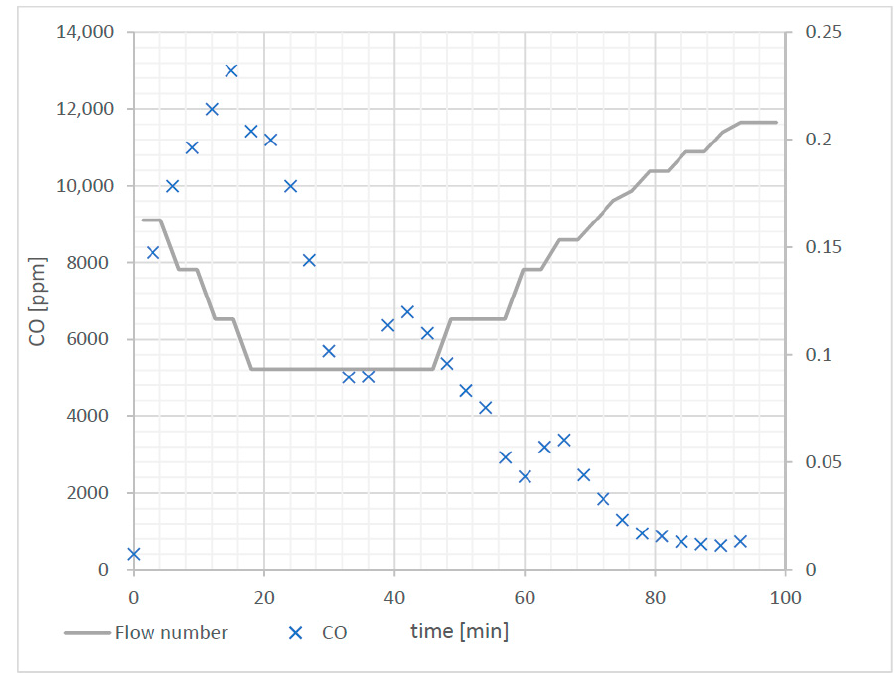
Figure 5. Development of CO at different flow rates over the whole period.